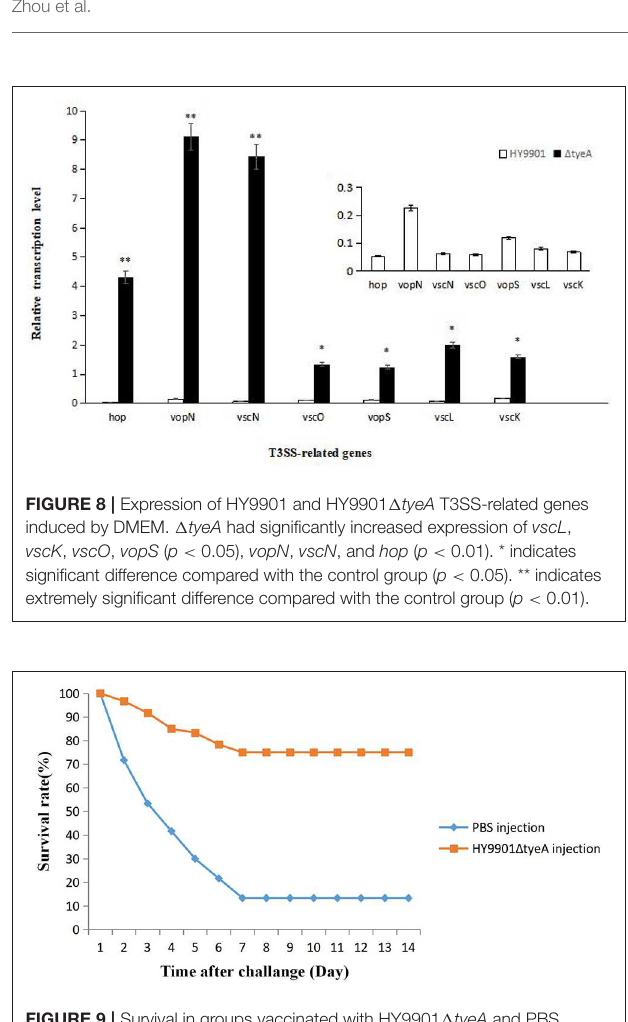
FIGURE 9 | Survival in groups vaccinated with HY9901 1 tyeA and PBS following challenge with Vibrio alginolyticus HY9901.